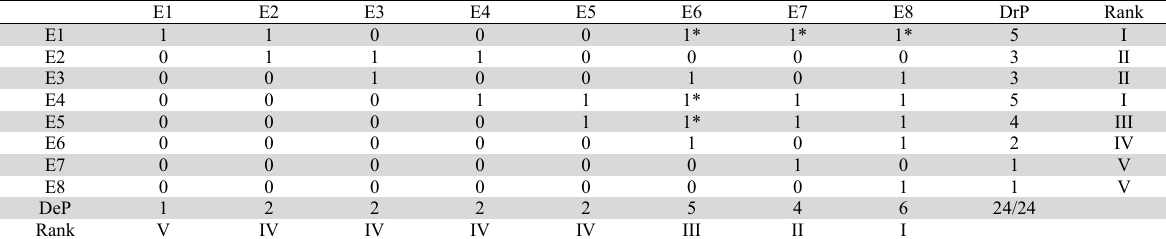
Final Reachability Matrix (FRM)